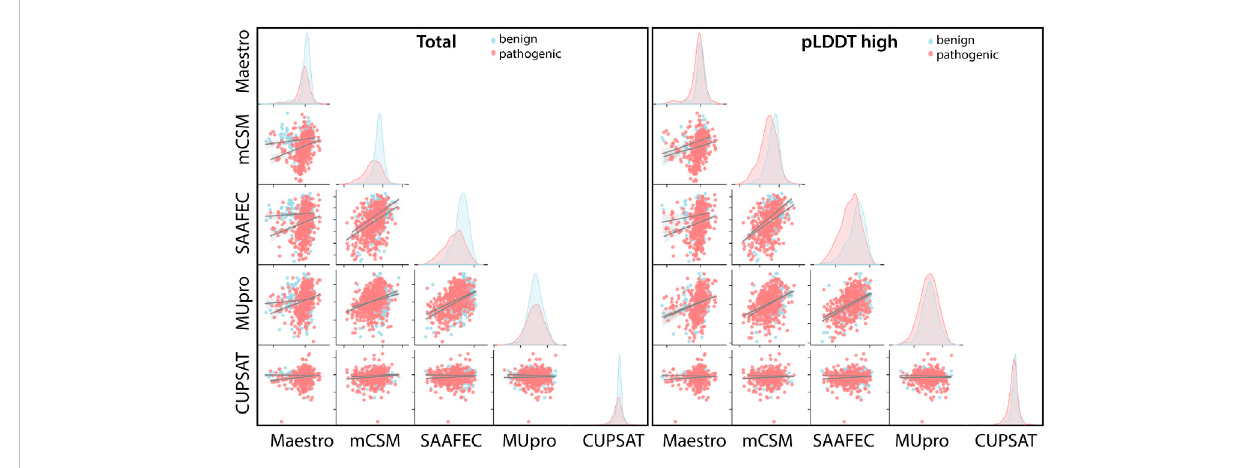
Cross-correlation of stability predictors for the total set and for the regions with high con fi dence (pLDDT high).